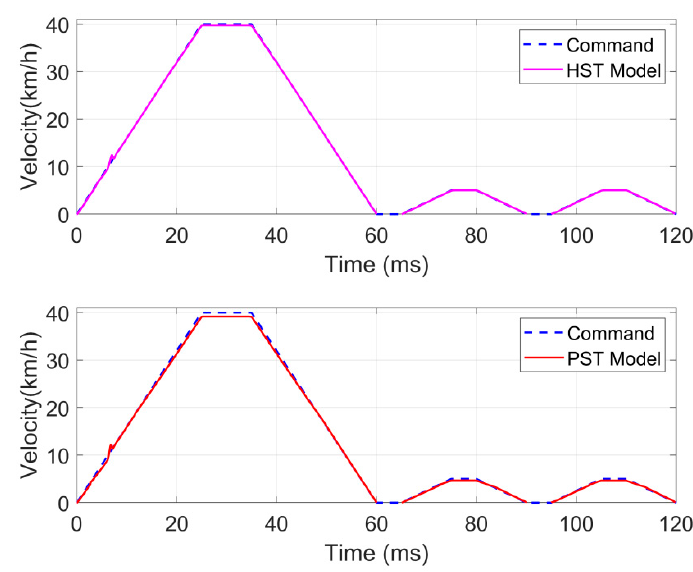
Figure 10. Commanded vehicle speed versus actual vehicle speed.